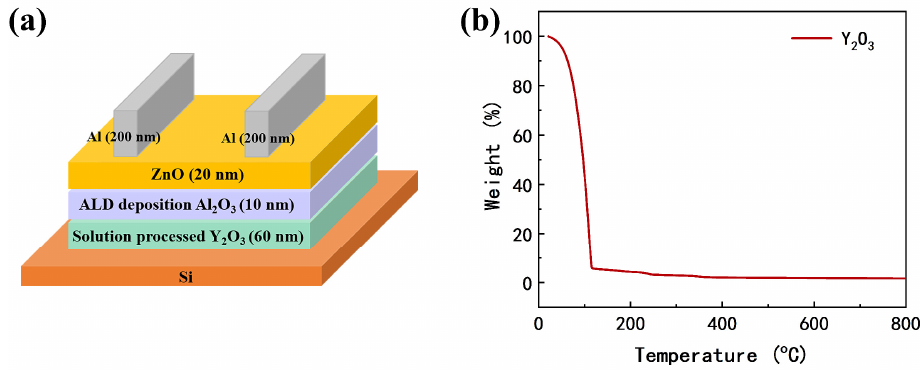
Figure 1. ( a ) The schematic structure of the ZnO TFT with Y 2 O 3 –Al 2 O 3 (ALD) as gate insulator. ( b )Thermogravimetric curve of precursor solution.